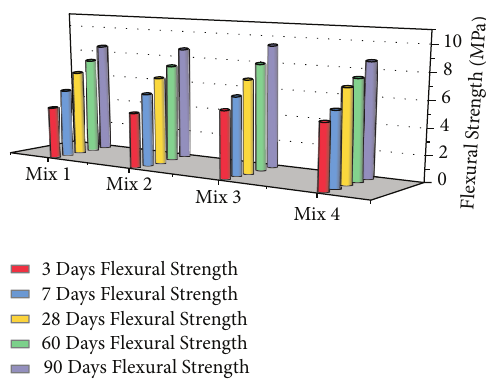
Figure 8: Graph of flexural strength for different mixes.